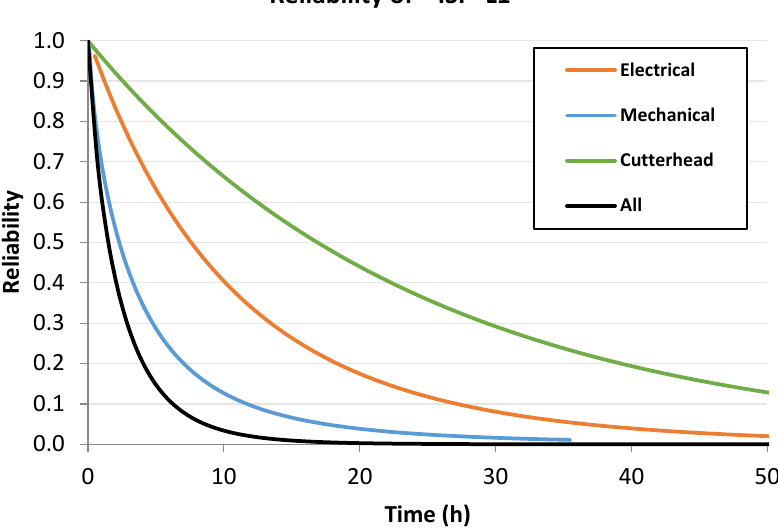
Figure 7. Reliability of the EPBM and all subsystems in Line 1.